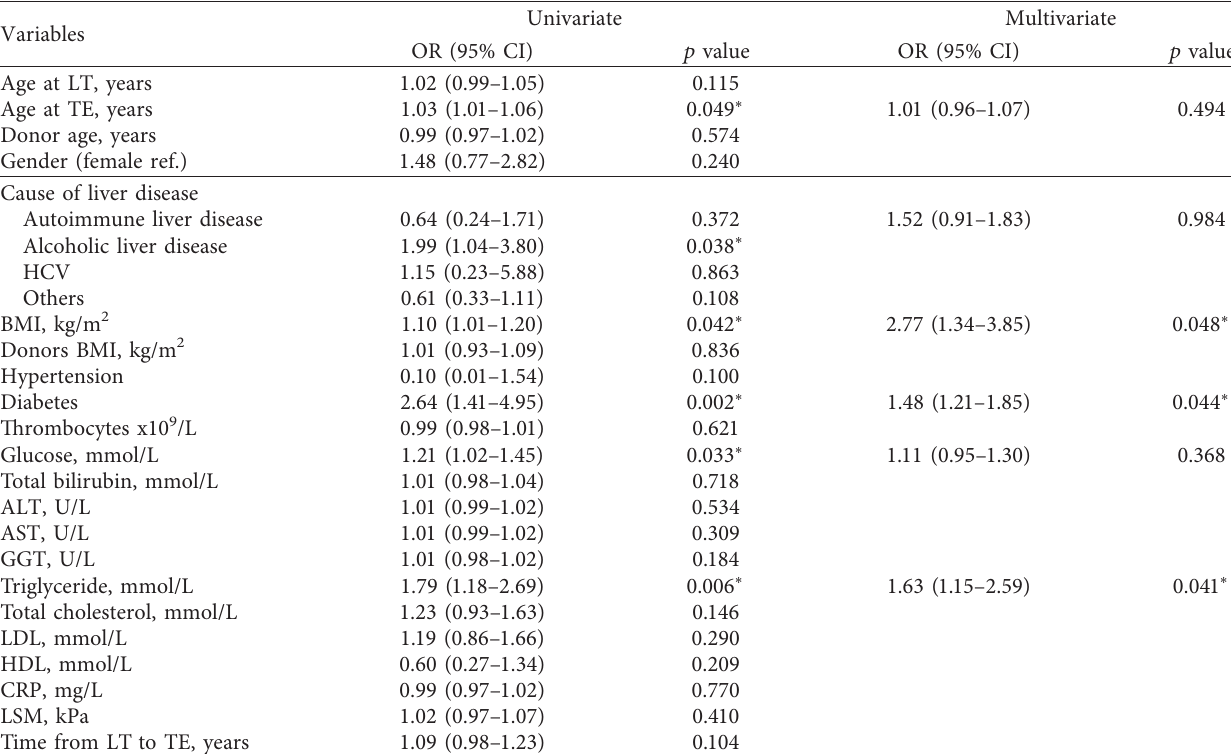
Table 4: Univariate and multivariate analysis of predictors of severe steatosis (elevated CAP ≥